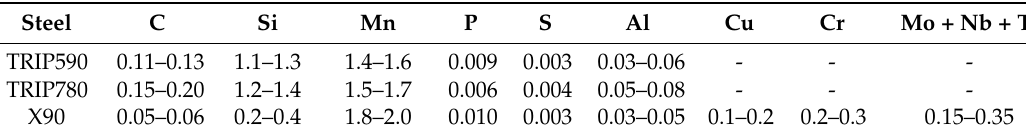
Table 1. The chemical composition of test steels